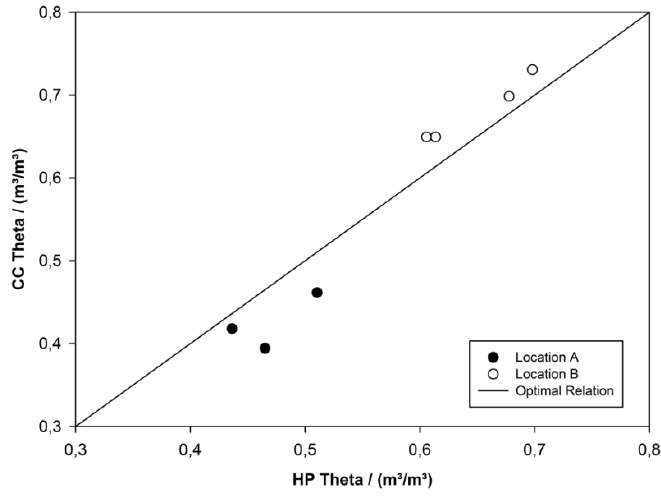
Figure 5. The field validation compares the volumetric water content determined with the calibrated Hydra Probe (HP Theta) and gravimetrically determined from cylindrical cores (CC Theta). HP Theta is related with the directly measured EpsR function. Two locations different in core size distribution and root content at the shore of the reed belt were sampled (A,